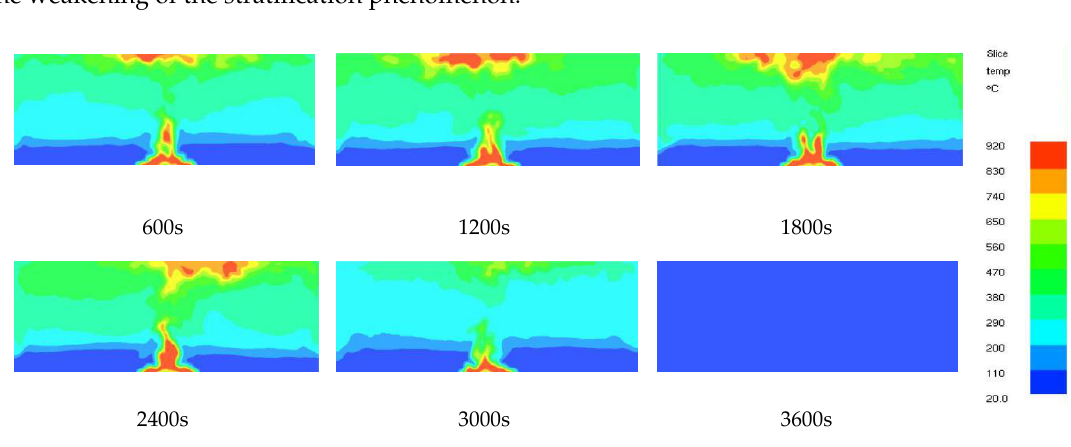
Figure 10. Slice temperature cloud (fire source location II).